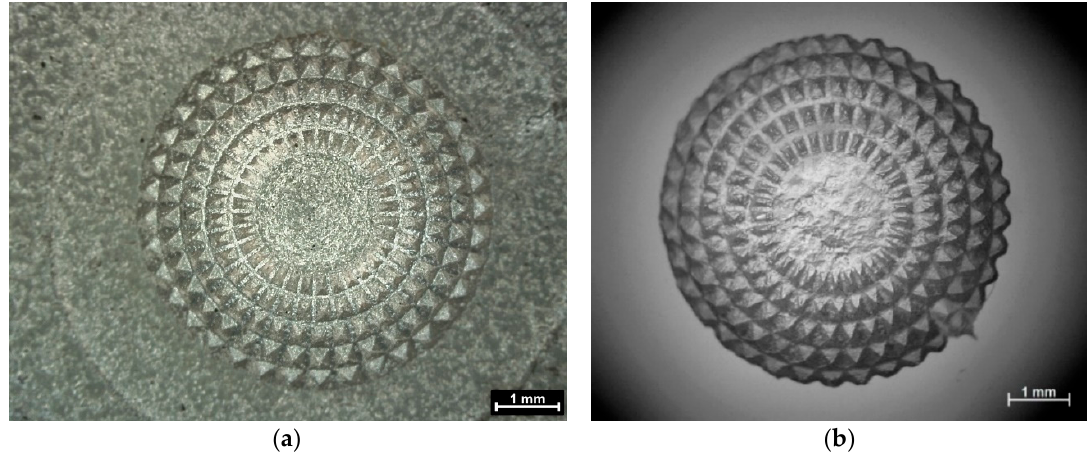
Figure 8. Image of disposable mold-insert produced by powder hot embossing ( a ) and the injected LED PMMA micropart ( b ).